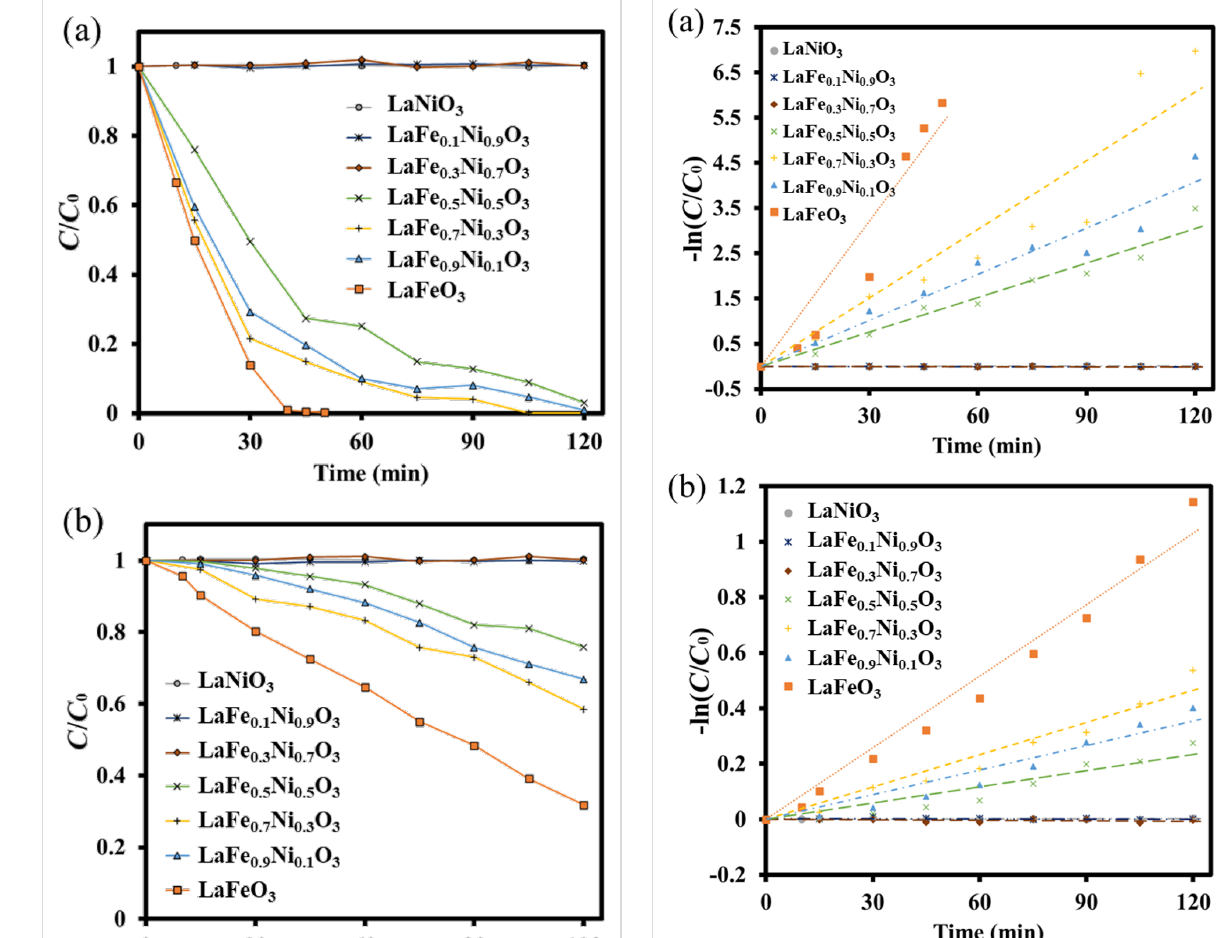
Table 1: The kinetic analysis of LaFe x Ni 1 − x O 3 perovskite oxides prepared at pH 0 and pH 7.